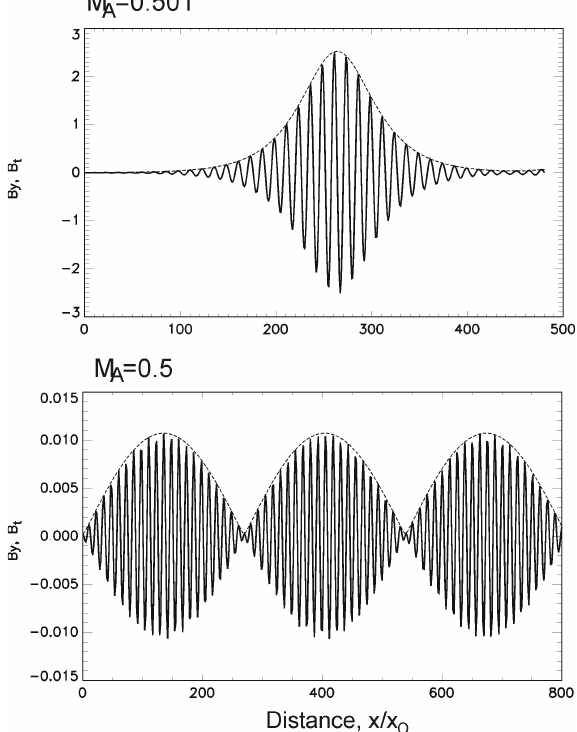
Fig. 11. The magnetic field variations (the component B y , and the amplitude B t = (B 2 y + B 2 z ) 1 / 2 ) in the whistler oscilliton and periodic wave